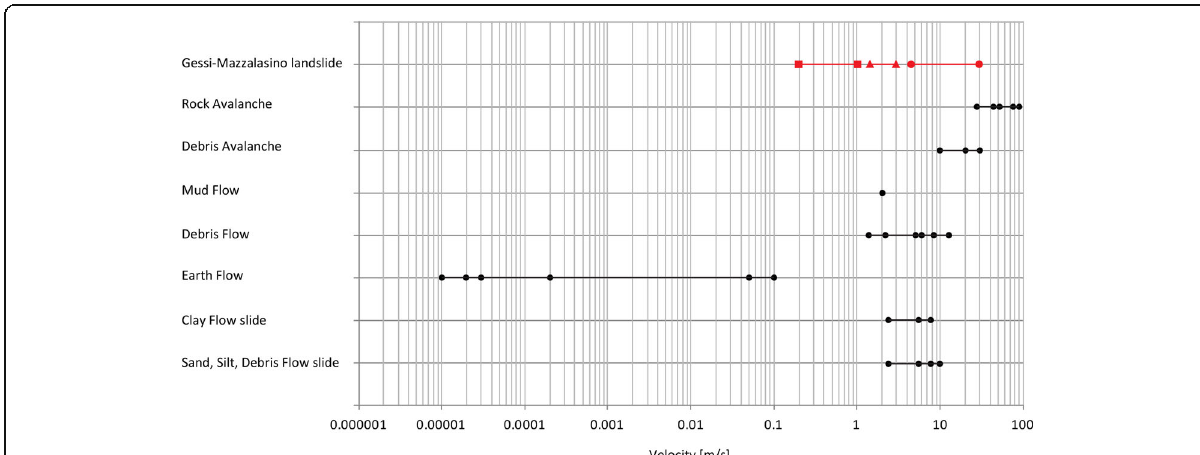
Fig. 14 Range of velocities for various types of flow-like landslides; the range of the estimated Gessi-Mazzalasino landslide velocity is shown in red (square symbols for resident testimonies, triangular symbols for empirical methods and circle symbols for numerical